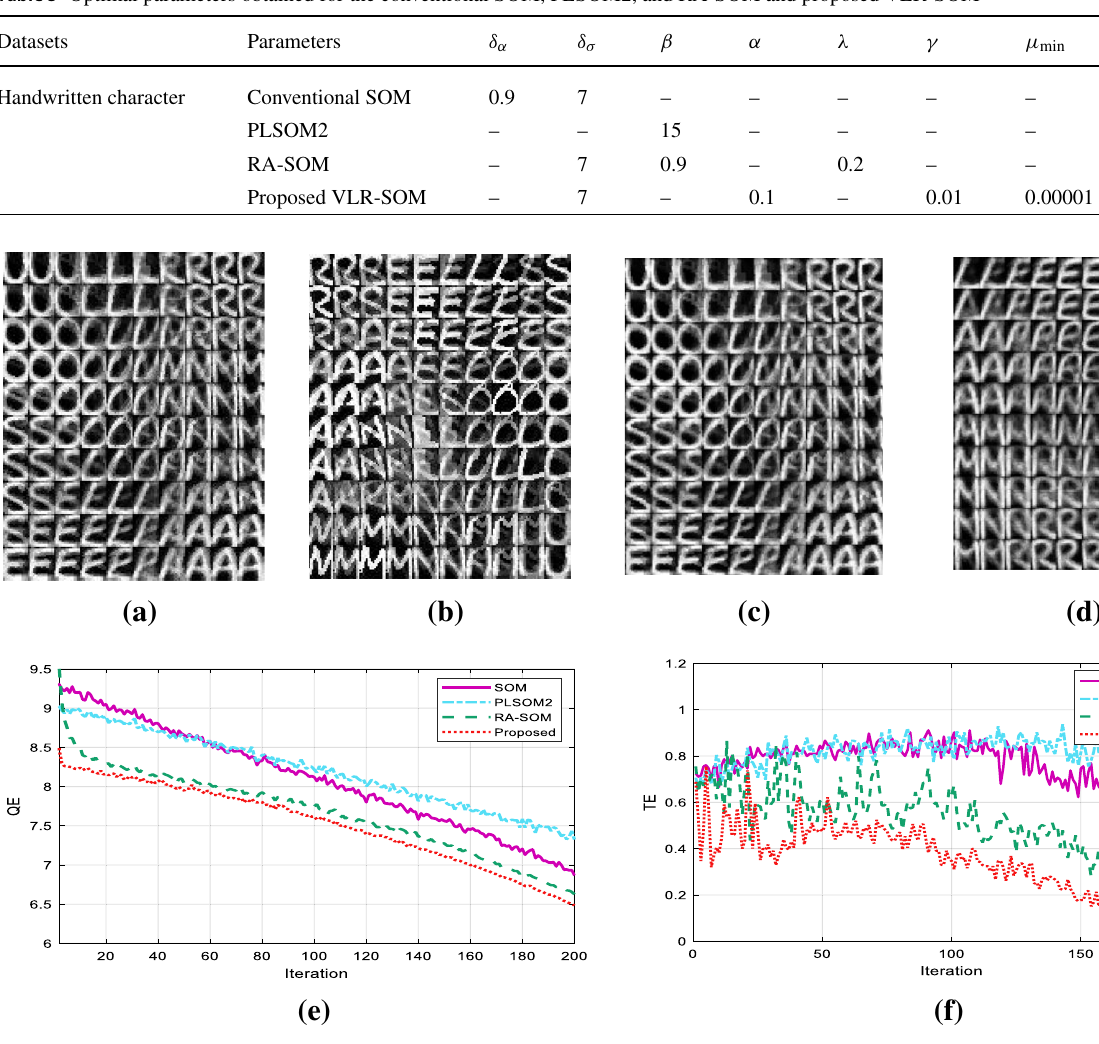
Fig. 5 Learning performance comparison of conventional SOM, PLSOM2, RA-SOM and proposed VLR-SOM algorithms using handwritten digits random initialization with 200 iterations: a Neighborhood construction behavior for Conventional SOM, Table 6 Comparison of conventional SOM, PLSOM2, RA-SOM, and proposed VLR-SOM algorithms for handwritten character recognition